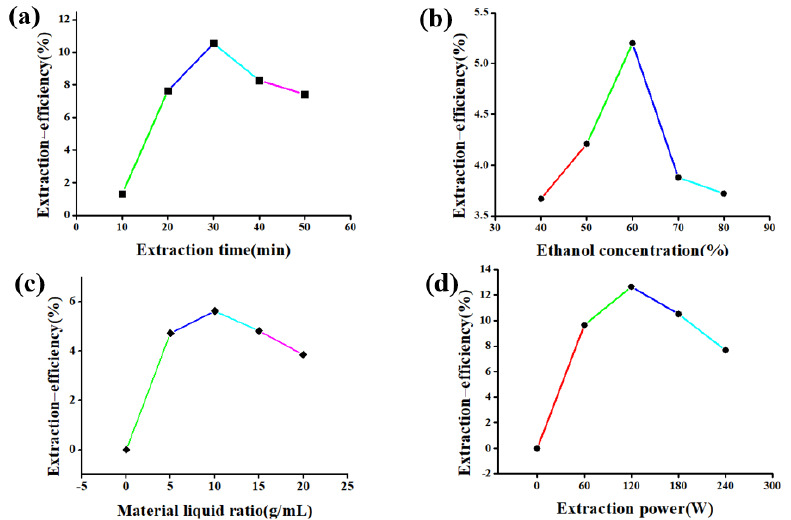
Figure 6. The effect of extraction time ( a ), ethanol concentration ( b ), material liquid ratio ( c ), extraction power ( d ).